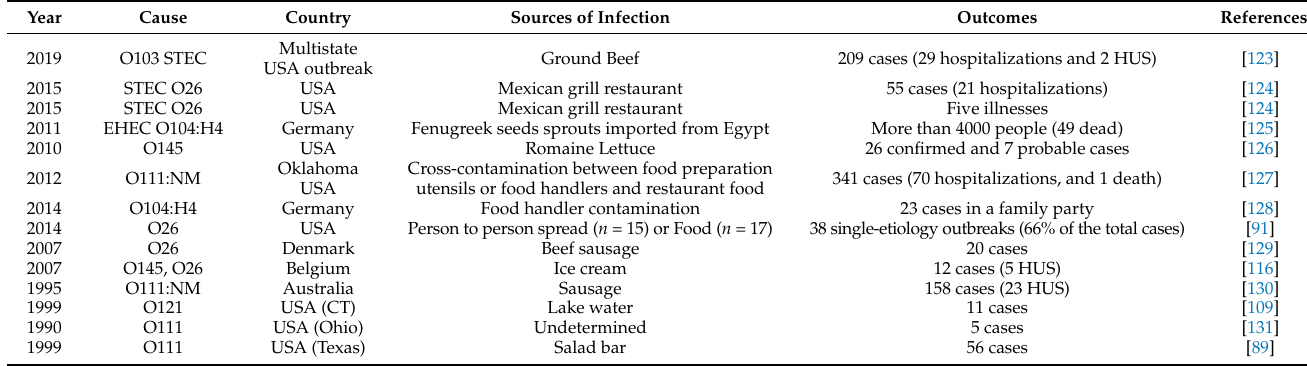
Table 1. Major outbreaks caused by non-O157:H7